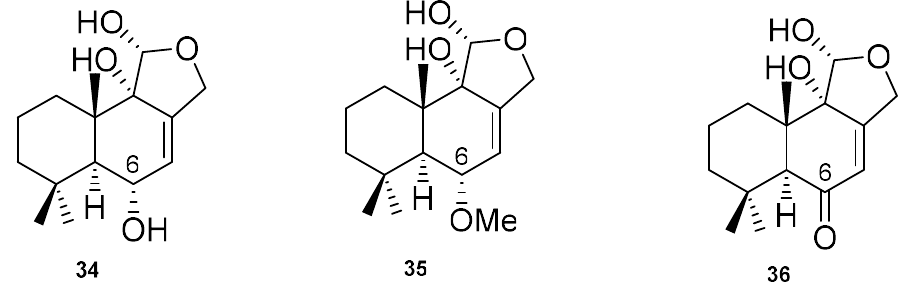
Figure 9. Cytotoxic drimane acetals from Perenniporia maackiae [55].